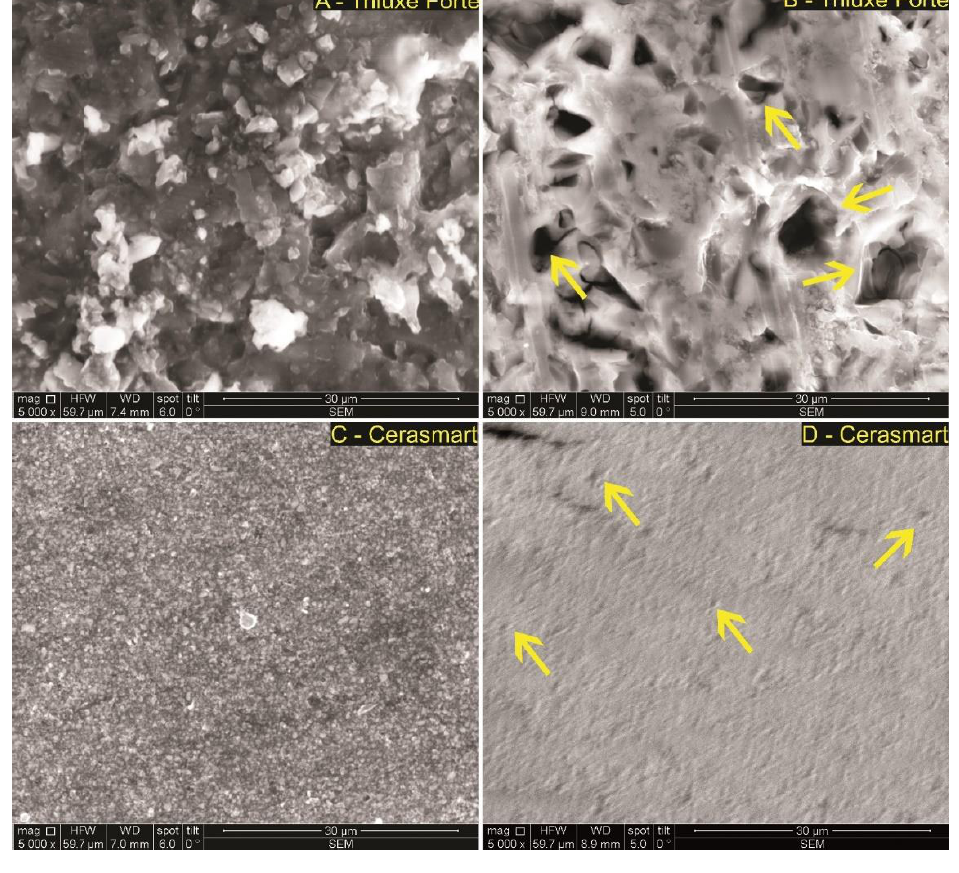
Figure 4. SEM images of Triluxe Forte and Cerasmart (( A , C )—before and ( B , D )—after exposure to simulated gastric acid solution) at 5000 × magnification and a 99.7 µ m horizontal field width. The yellow arrows represent changes that occurred after simulated gastric acid exposure. The non- exposed samples to simulated gastric acid solution exhibited a micro-roughness surface ( C ) and an increased roughness in sample ( A ). The exposed samples to simulated gastric acid solution ( B , D ) presented a clear surface with a polished aspect with obvious pores indicated by yellow arrows ( B ) and a lack of micro-roughness surface aspect with a few pores indicated also by yellow arrows ( D ).